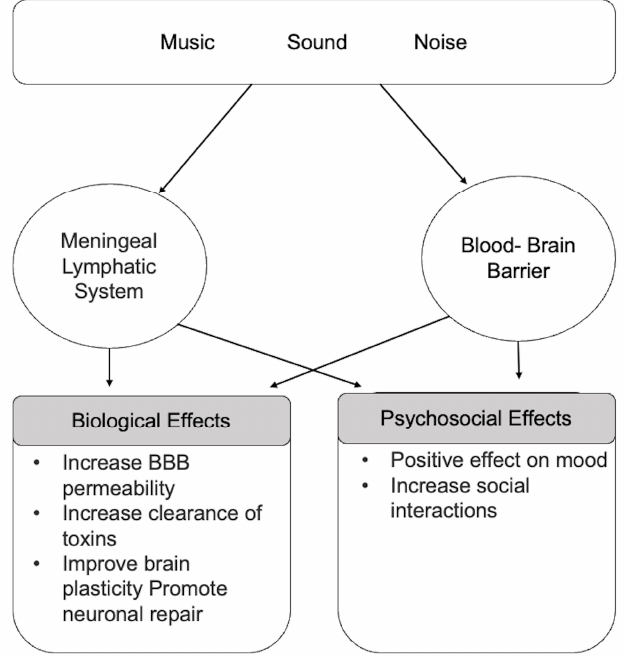
Figure 2. Relationship between music/sound exposure on meningeal lymphatic system/glymphatic system and blood–brain barrier function. The illustration depicts important outcomes that arise from music/sound exposure on the meningeal lymphatic/glymphatic system. The bullets emphasize the main points of these studies and this review.